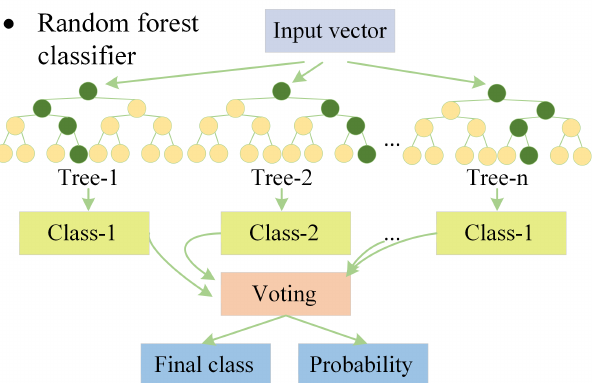
Figure 3. The random forest classifier. The random forest outputs the final class and probabilities based on the voting